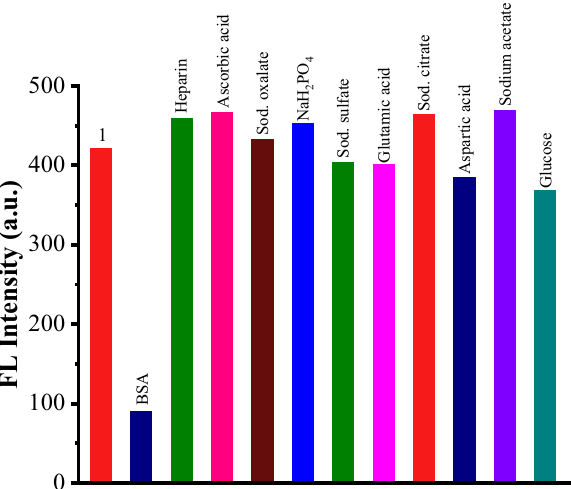
Figure 6. Fluorescence emission responses of TPE-kana 1 toward BSA (120 nM) and its other biological competitors (120 nM) at 476 nm in D/W.